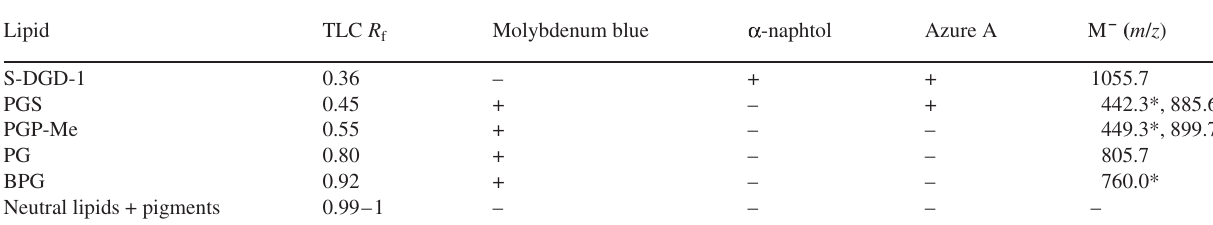
Table 1. Characterizationof the totalpolarlipidsextractedfrom Haloquadratum walsbyi . The polarlipidswere separatedby thinlayerchromatog- raphy (TLC) and stained with molybdenum blue (phosphate), α -naphtol (reducing sugar) and Azure A (sulfate) reagent. M – ( m/z ) was deter- mined by ESI-MS for each isolated and purified lipid component. Asterisks (*) indicate bicharged molecular ion [M – 2H] 2– .